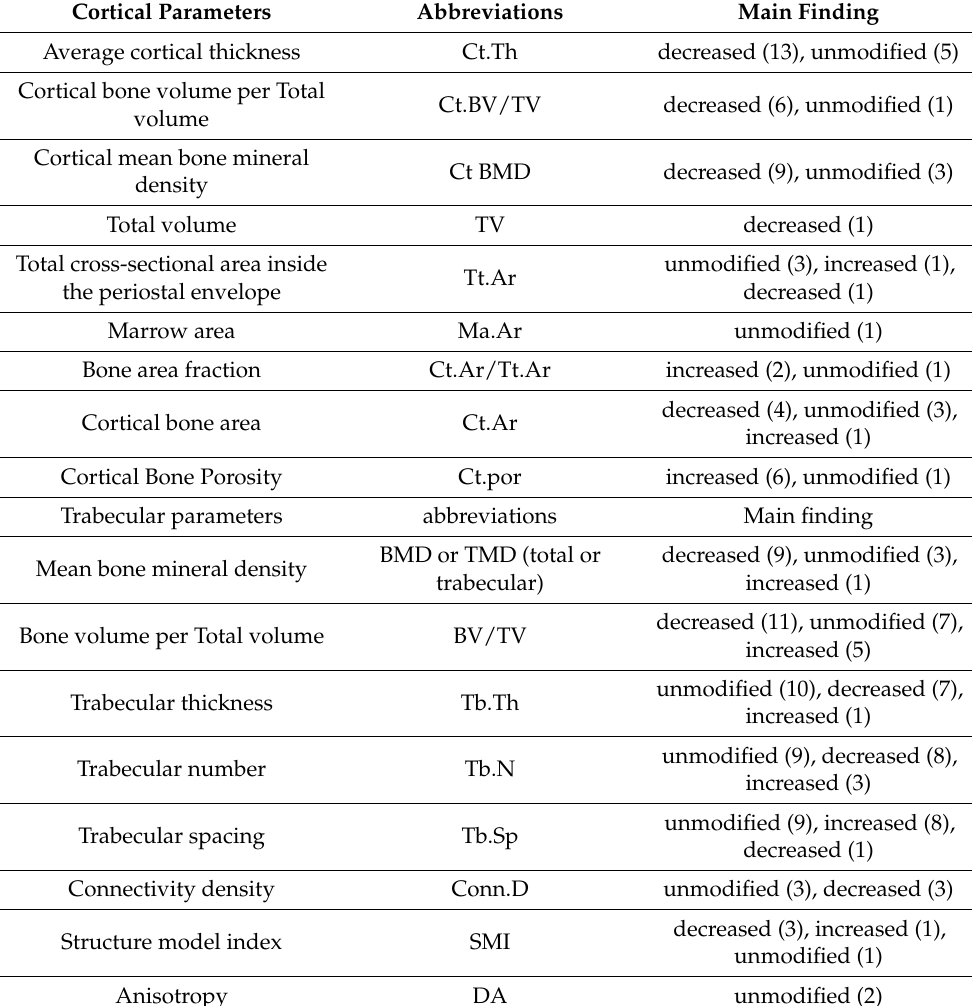
Table 4. Micro-CT and P-QCT findings based on the articles reviewed and listed in Table 1. Only findings of mice with CKD on normal and high phosphate diets are depicted, but no findings from specific intervention